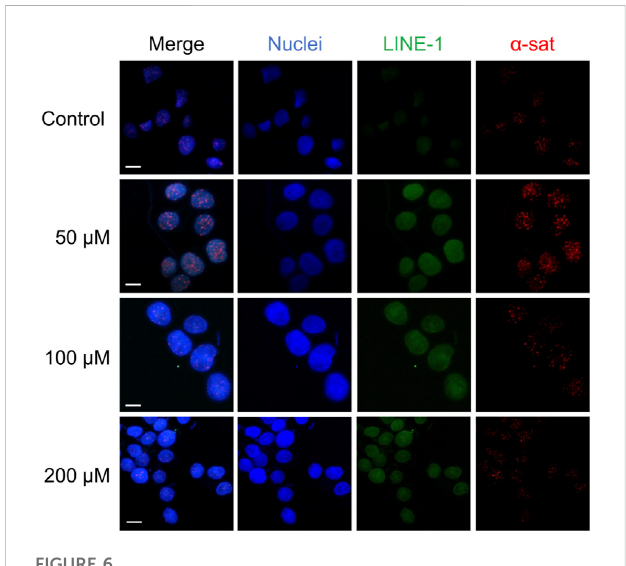
FIGURE 6 The microscopic images of HepG2 cells treated with various concentrations of Al (III). The nuclei were labelled by DAPI (blue). Scale bars, 10 μ m.